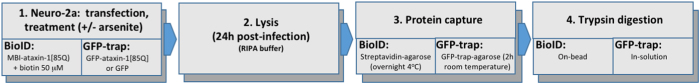
Work flow of sample preparation for mass spectrometry analysis.Following transfection to express MBI-ataxin-1[85Q], GFP-ataxin-1[85Q] or GFP only, Neuro-2a cells were incubated with/without (+/−) pro-oxidant arsenite stress. Cells were lysed, then proteins captured by streptavidin-agarose in the BIoID protocol, or by GFP-Trap. Incubation with trypsin followed on-bead (BioID) or in-solution (GFP-Trap) methods to produce peptides for further mass spectrometry analysis.